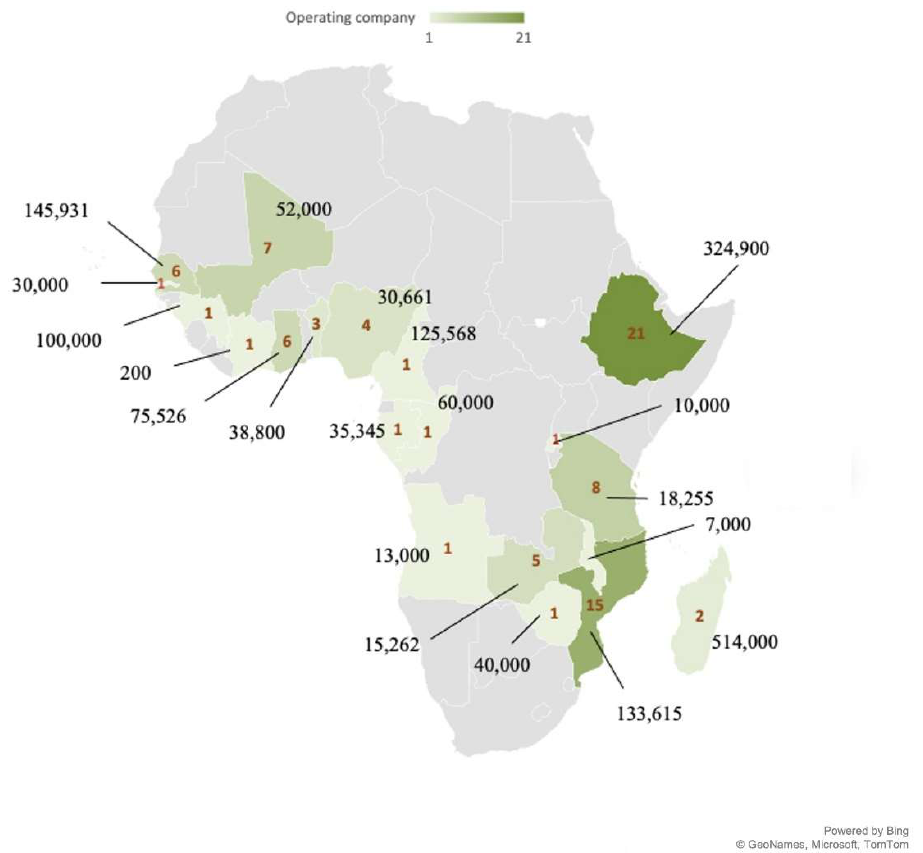
Figure 5. Choropleth map representing the total companies concerning biofuels in each country (numbers in orange), linked to the total area (ha) acquired (numbers in black). Based on the Land Matrix database 2021 [43].